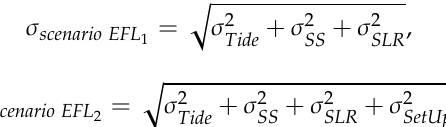
Table 4. Extreme Flood Hazard Index (EFHI) classification levels and respective conditional probability interval for an SLR scenario, relative to the respective central flooding elevation reference level (EFHI levels are related with color scale of hazard mapping, from 1—Light Blue to 5—Dark Blue).